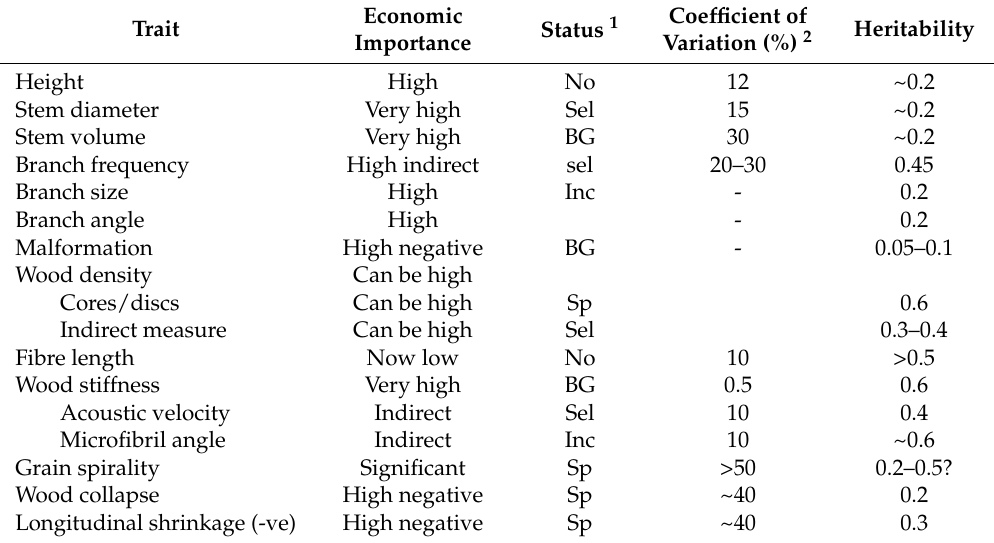
Table 3. General importance, status in breeding programme, and indicative information on variation and heritability for some individual traits in radiata pine (mainly after [8] Table 5.5,